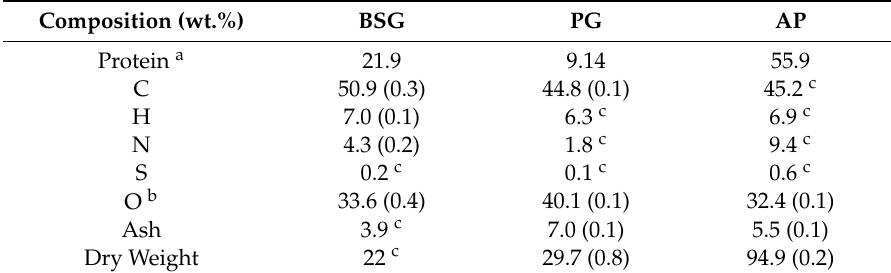
Table 2. The composition of the three feedstock materials. Composition